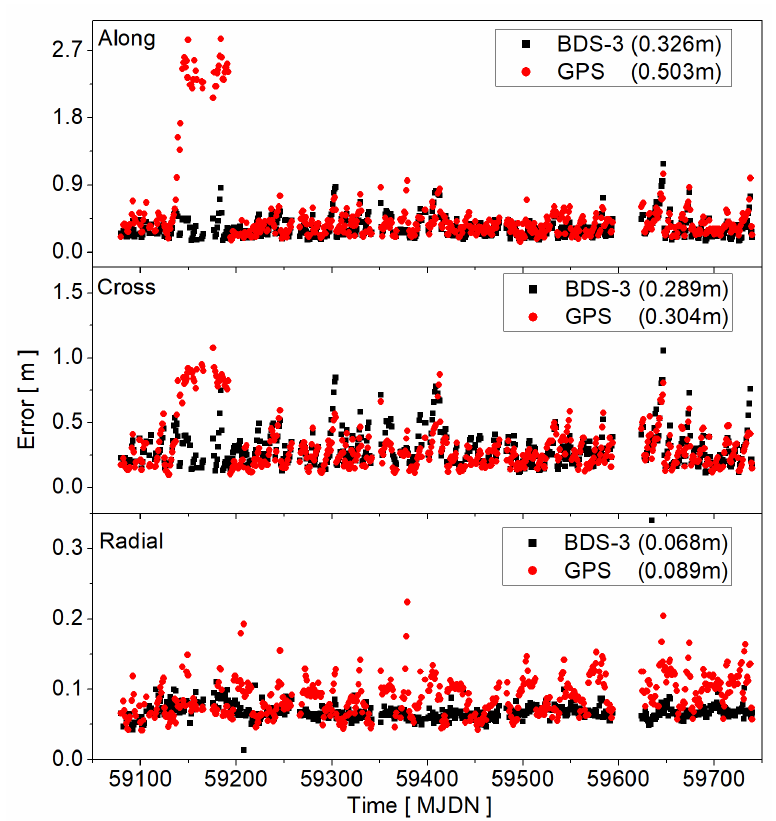
Figure 5. Time series of satellite orbit error for PPP-B2b products; Black squares and red cycles represent BDS-3 and GPS, respectively; top, middle, and bottom panels are the RMS of satellite orbit in Along, Cross, and Radial directions, respectively.